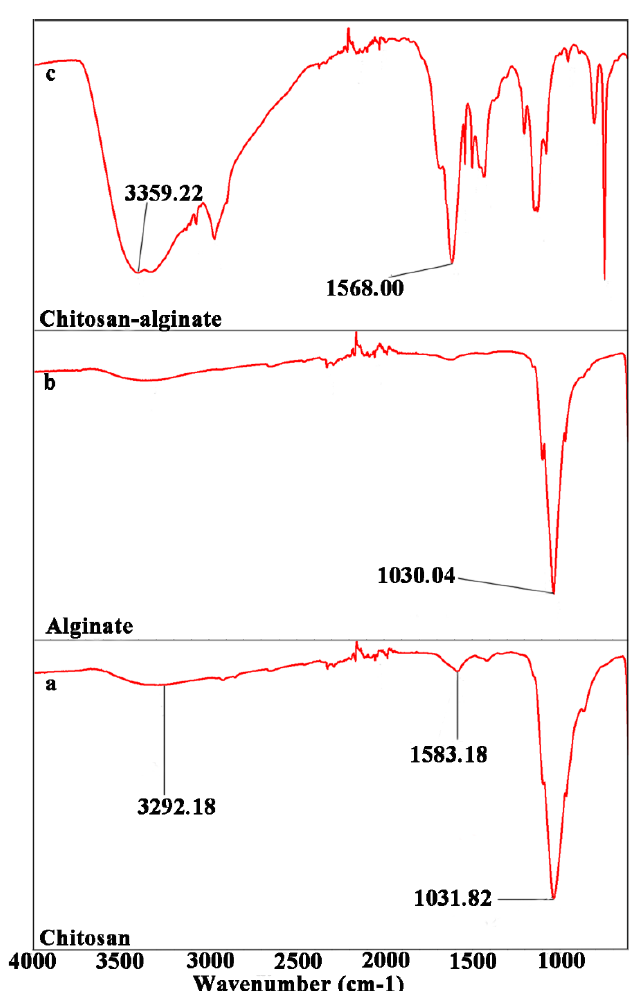
Figure 4. Fourier transform infrared (FTIR) spectroscopy evaluation of chitosan ( a ), alginate ( b ), and chitosan-alginate polyelectrolyte complexes ( c ).